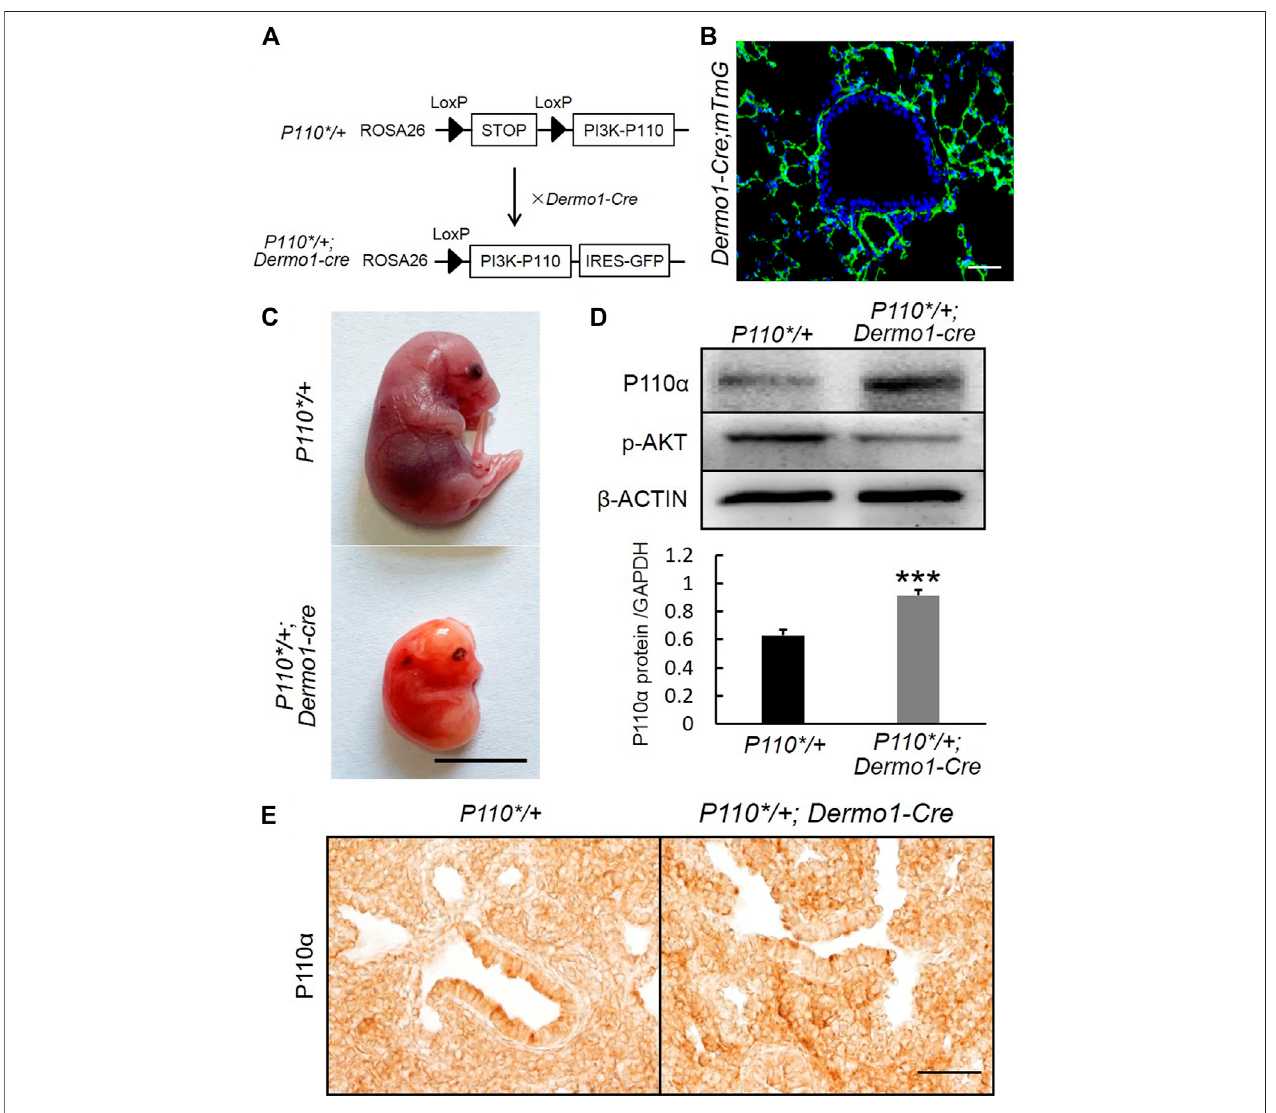
FIGURE 1 | Generation of P110*/+; Dermo1-cre mice. (A) . P110*/+ ; Dermo1-cre was generated by crossing P110*/* with Dermo1-Cre mice. (B) . An IF staining analysis showed GFP-labeled mesenchymal cells in Dermo1-Cre; ROSA mTmG mice. Scale bar: 50 μ m. (C) . Gross morphology of E20.5 control and P110*/+ ; Dermo1- cre embryos. Scale bar: 1 cm. (D) . The expression of p110 α and phosphorylated AKT at E12.5 were analyzed by using western blot. The western blot result for p110 α was quanti fi ed with ImageJ software. (E) . Immunolocalization of P110 α in E17.5 control and P110*/+; Dermo1-cre lungs. Scale bar: 50 μ m.